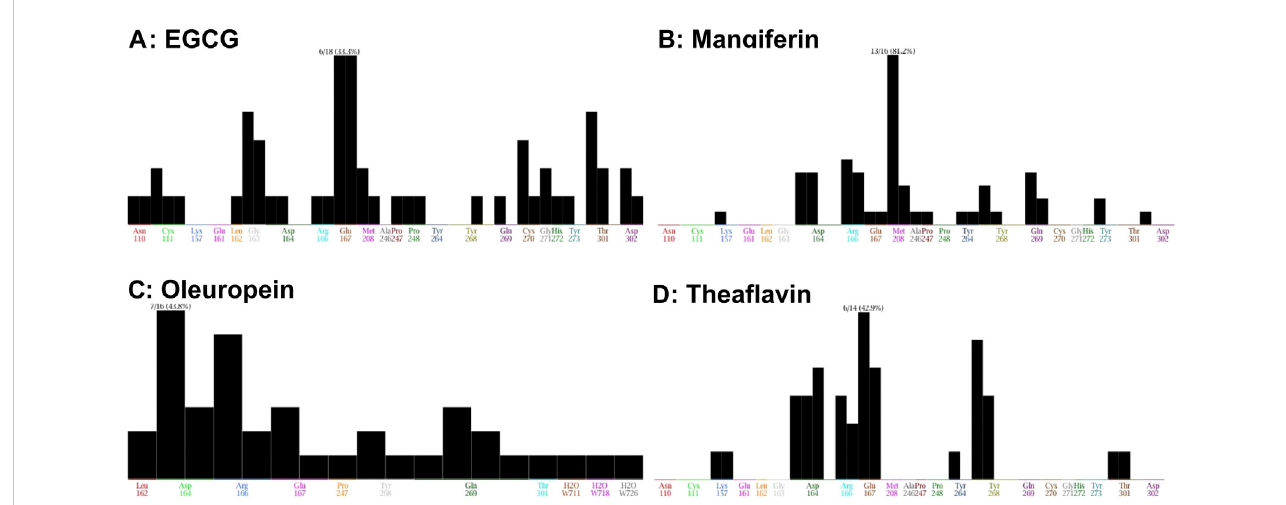
FIGURE 8 Fingerprinting population map of SARS-CoV-2 PLpro-ligand interaction. (A) EGCG shows a stronger interaction strength with Glu 167 than Tyr 268 . (B) Mangiferin demonstrates a stronger interaction strength with Tyr 268 . (C) Oleuropein shows a weak interaction with Tyr 268 . (D) Thea fl avin shows a weaker interaction with Tyr 268 than Glu 167 of PLpro but this interaction is stronger than EGCG, Mangiferin, and Oleuropein. The interaction of the molecules with speci fi c amino acids of PLpro enzyme are represented as black